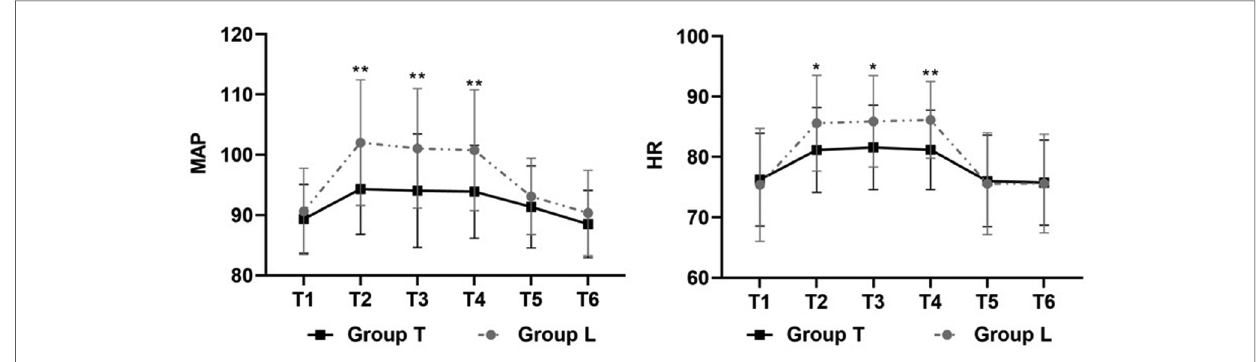
FIGURE 3 The level of MAP and HR. The Student ’ s t -test was performed to detect the difference between the groups. ** P <0.001.